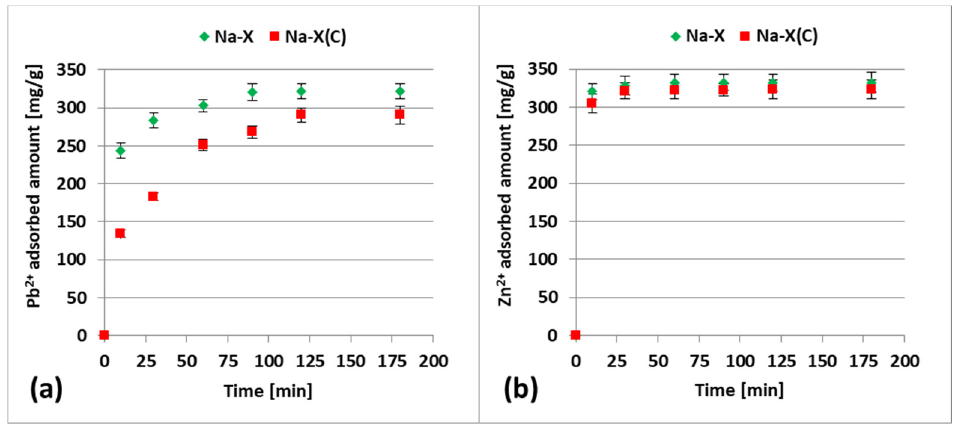
Figure 6. Adsorption kinetics of Pb 2+ ( a ) and Zn 2+ ( b ) on the Na-X and Na-X(C) surface in the single systems, at pH 5.